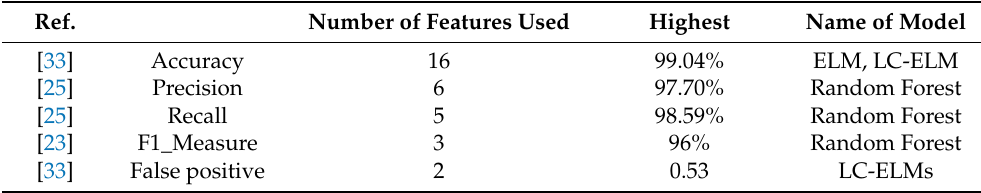
Table 3. Highest results of classifiers.